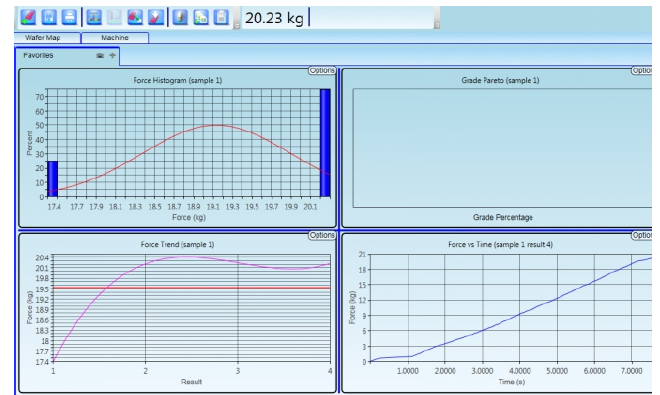
Figure 12. Schematic diagram of the pushing of the ball.